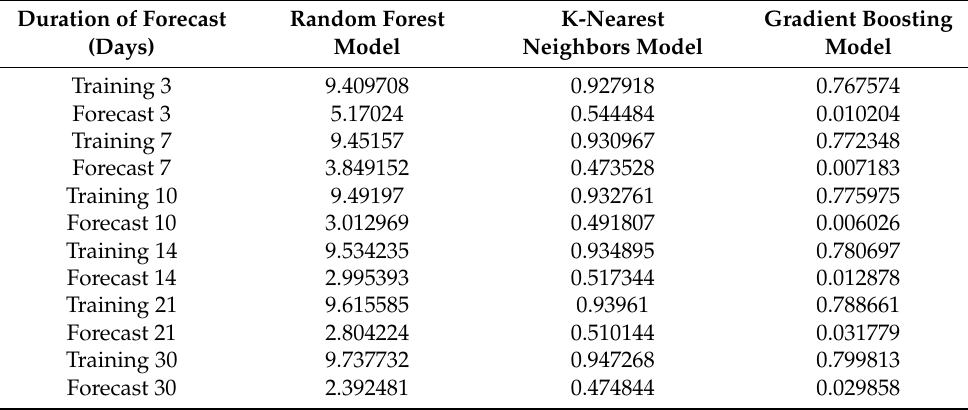
Table 1. Relative error of forecasted new cases for Germany (%).